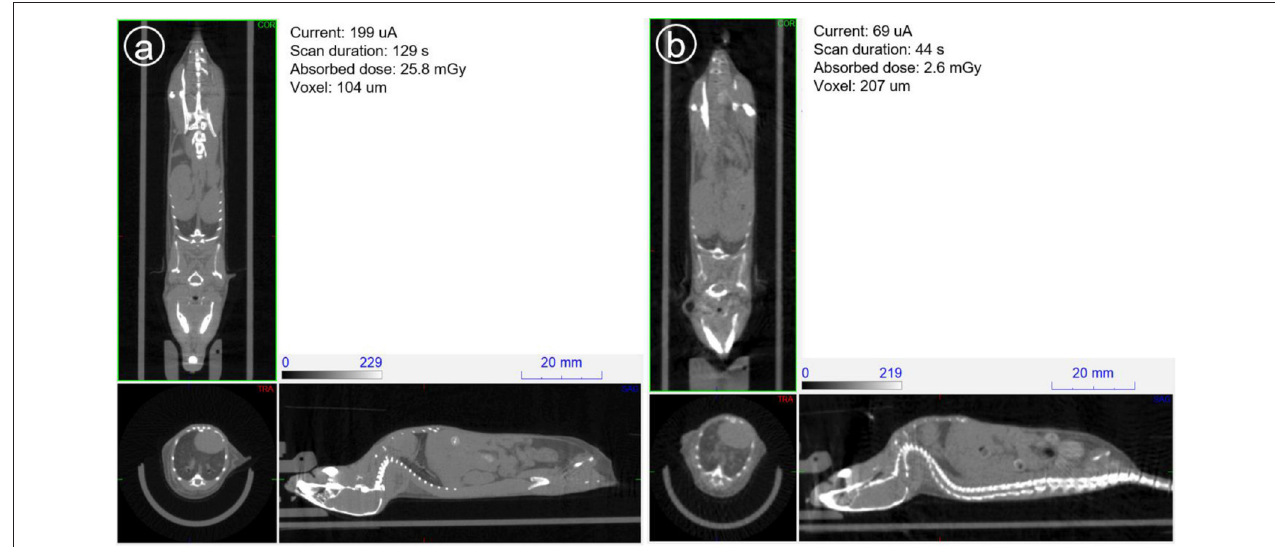
FIGURE 13 | Mouse scanned at 39 kV and aluminum filtering of 1mm. (a) On the left with typical imaging settings and (b) on the right, current and scan duration optimized to minimize dose.